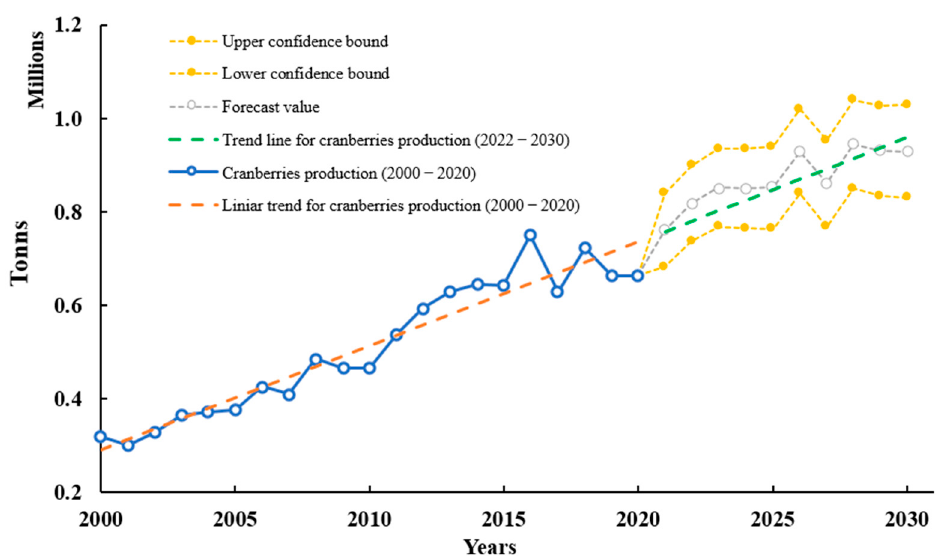
Figure 2. Evolution of world cranberry production over time. According to FAO, global cranberry production (tons) from 2000 until 2030 and TREND production until 2030. The trendline was calculated considering cranberry production every year from 2000–2020. The TREND function returns values along with a linear trend. It fits a straight line (using the least squares method) to the arrays known_ys and known_xs. TREND returns the y–values along that line for the array of new_xs that you specify.